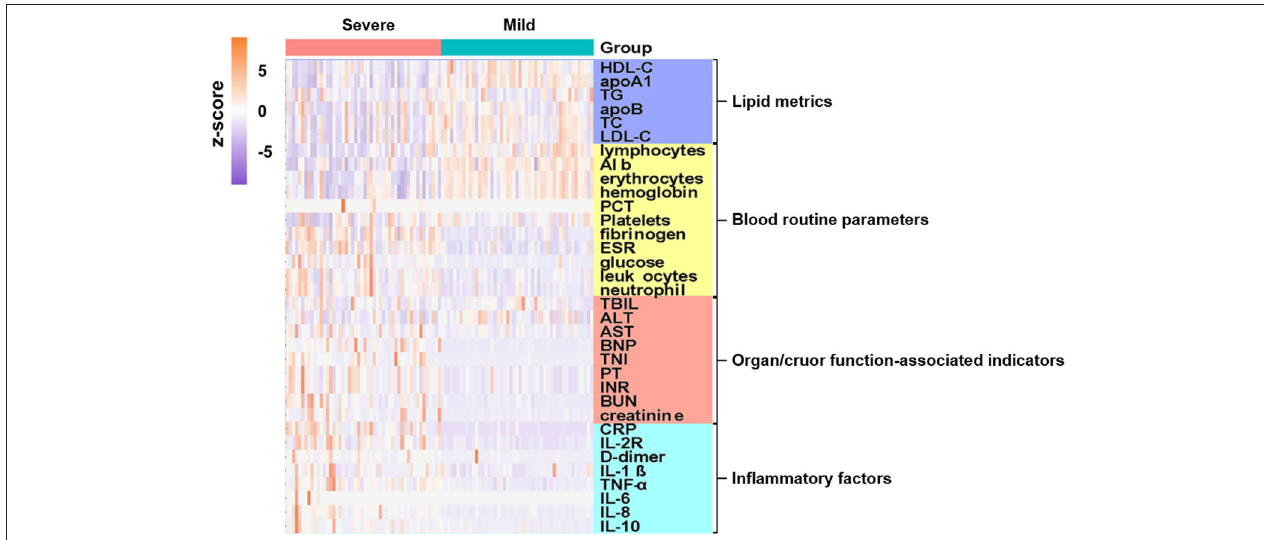
FIGURE 1 | Admission characteristics of laboratory parameters between mild and severe COVID-19 patients. Hierarchical clustering was applied based on laboratory parameters. Heatmap indicates enriched concentration of laboratory indicators in mild and severe cases. Levels of laboratory metrics were scaled by calculating z-scores (subtracting mean, then dividing by standard deviation of each row). Laboratory metrics were categorized into four major groups, i.e., lipid metrics, routine blood parameters, organ/cruor function-associated indicators, and inflammatory factors, with color bars on right side of plot indicating each analyte category. Y-axis represents laboratory values after z-scoring by row; x-axis represents individual cases. Annotations show severe cases in pink and mild cases in cyan.